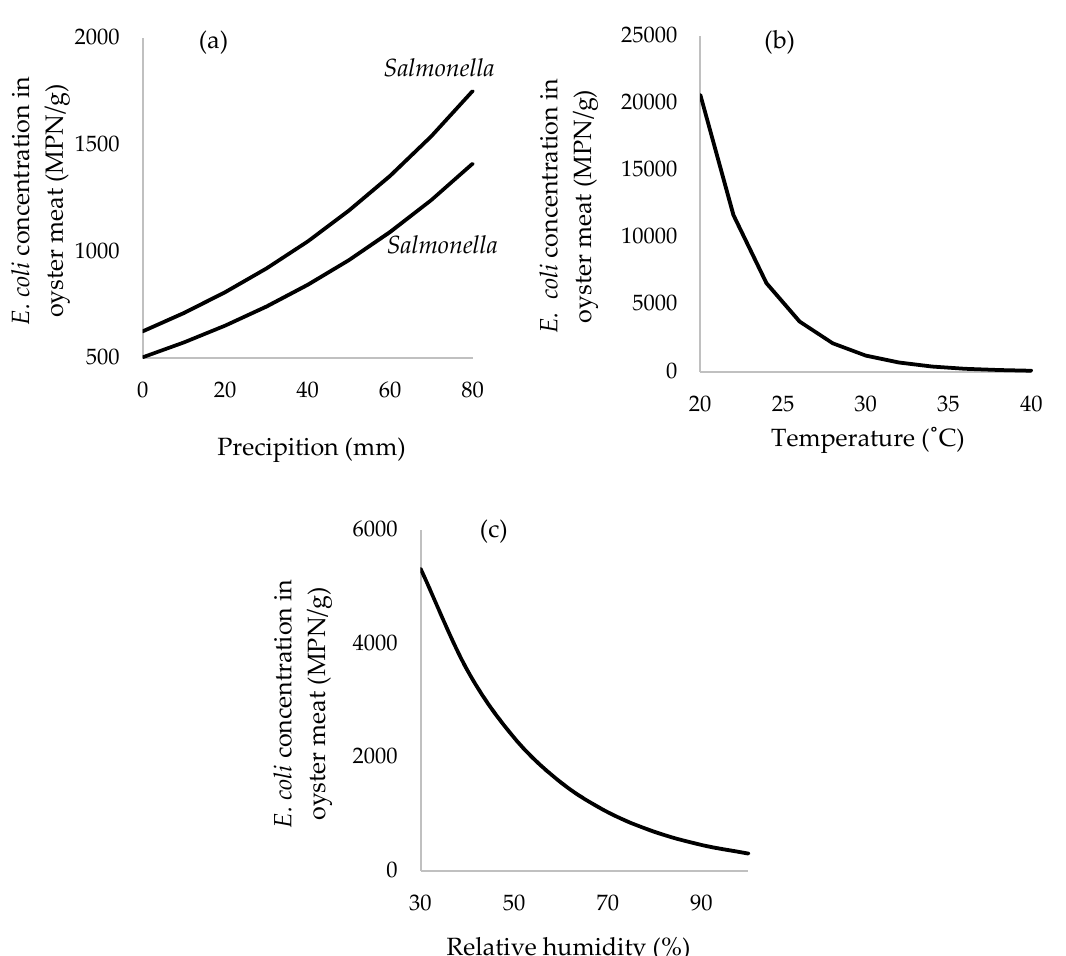
Akaike Information Criteria (AIC) = 981.05. 1 The 95% confidence interval (CI) and p -values were adjusted for potential intra-group correlation within oyster sampling locations; 2 FC = fecal coliforms (MPN/100 mL of estuarine water).